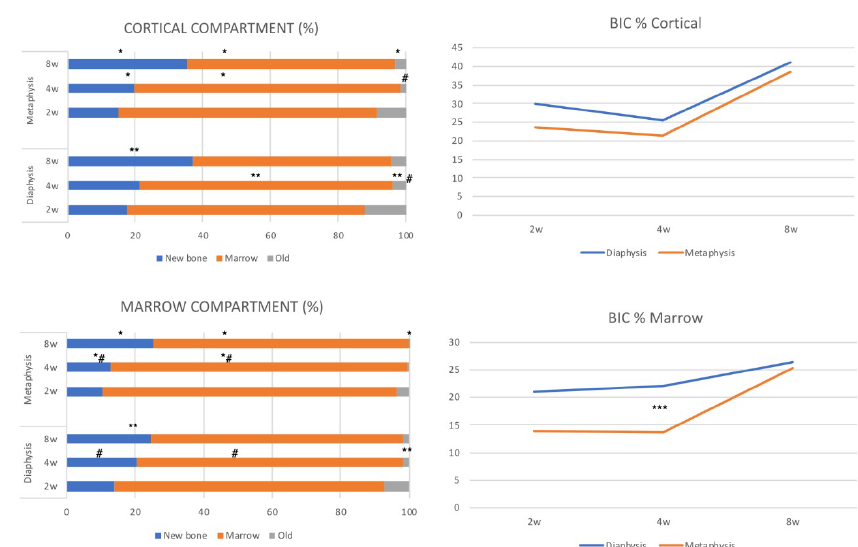
Figure 3. The total amount of new bone, marrow content, and old bone according to cortical ( a ) and marrow ( b ) compartment for implants placed via either diaphysis (n = 9) or metaphysis (n = 9) at different healing periods. Mineralized bone to implant contact (new + old) for cortical ( b ) and marrow ( d ) compartments at the various healing times. p < 0.05; between cortical and marrow compartments at metaphysis sites (*), at diaphysis sites (**) or (#) between diaphysis and metaphysis within cortical and marrow compartments and (***) for mineralized bone to implant contact, respectively. Comparisons are based on the same healing stage in weeks (w).